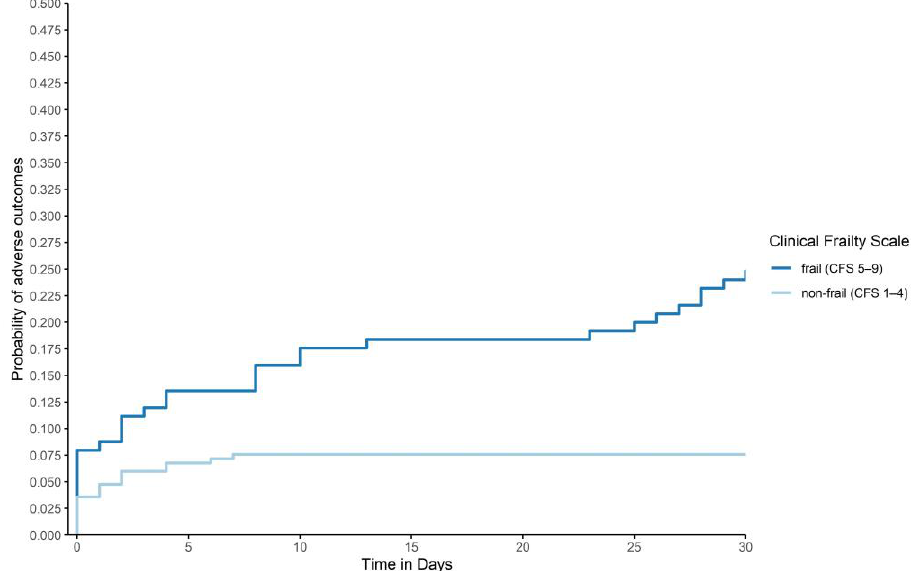
Figure 2. Adverse outcomes by frailty status: Graphical description of adverse outcomes (30-day-mortality or 30-day-ICU-admission) based on Cox regression with frailty status as strata, adjusted for age and gender. Frailty- levels were collapsed to “frail” (CFS 5 – 9 ) and “non - frail” (CFS 1 – 4). To improve readability, the graph was cropped to 0.5 on the y axis. ( p < 0.001, p -value based on logistic regression).